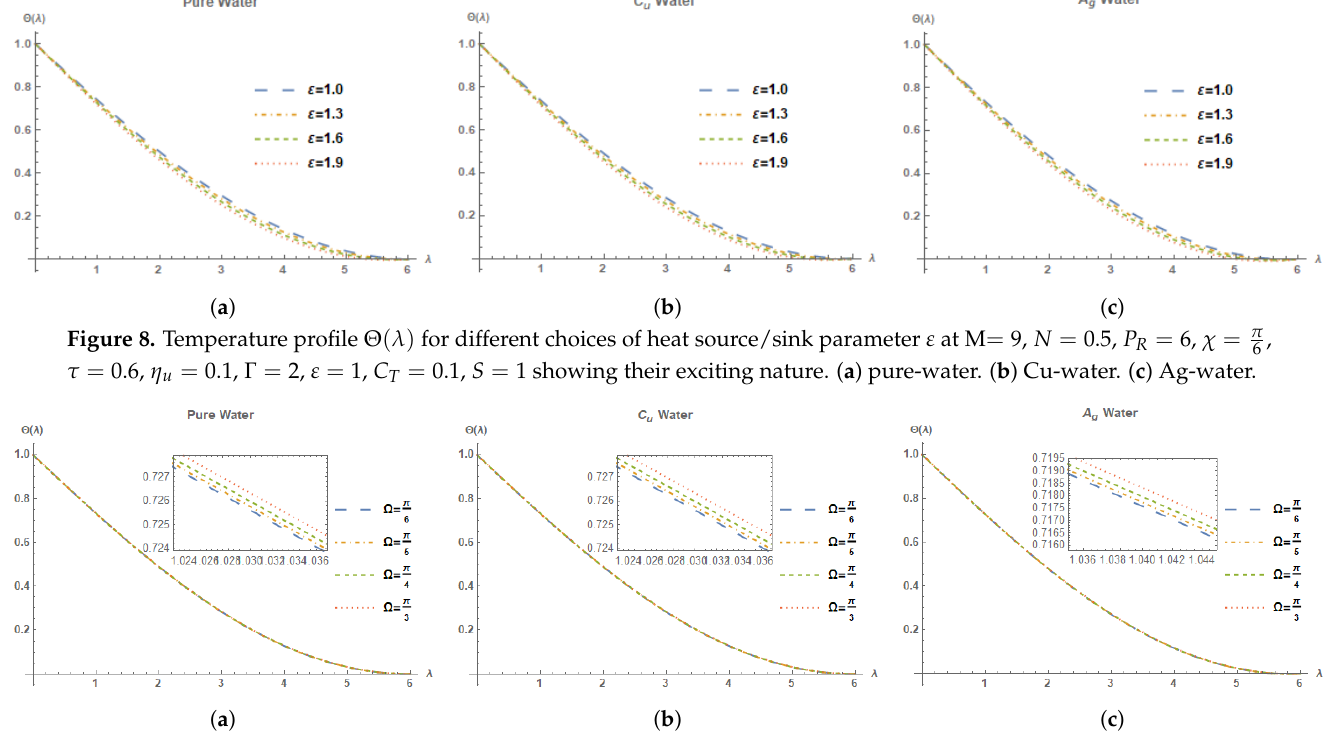
Figure 9. Temperature profile Θ ( λ ) for different choices of angle of wedge χ at M = 9, N = 0.5, P R = 6, ε = 1, τ = 0.6, η u = 0.1, Γ = 2, ε = 1, C T = 0.1, S = 1 showing their exciting nature. ( a ) pure-water. ( b ) Cu-water. ( c ) Ag-water.